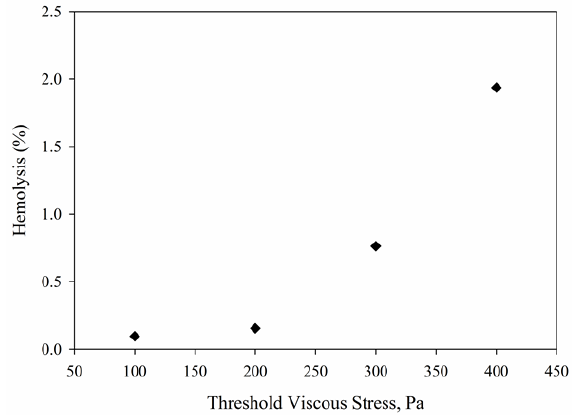
Figure 9. Relationship of hemolysis to threshold viscous stresses in capillary tube for all experiments (400 to 100 Pa).